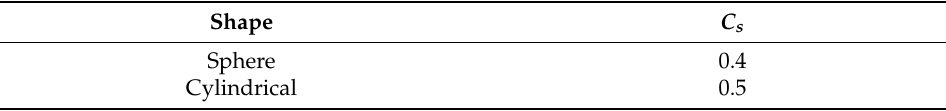
Table 4. Shape coefficient C s for windages. Shape